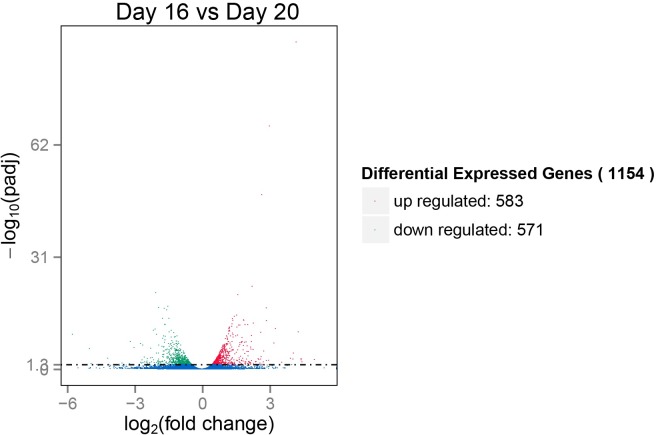
Volcano plot displaying DEGs within two different comparison groups.Note: the y-axis shows the mean expression value of log10(q-value), and the x-axis displays the log2fold change value. The blue dots represent the transcripts that did not reach statistical significance (q > 0.05); the red (up-regulated) and green dots (down-regulated) represent those whose expression levels were significantly different (q < 0.05); the blue dots represent the transcripts did not reach statistical significance (q > 0.05).